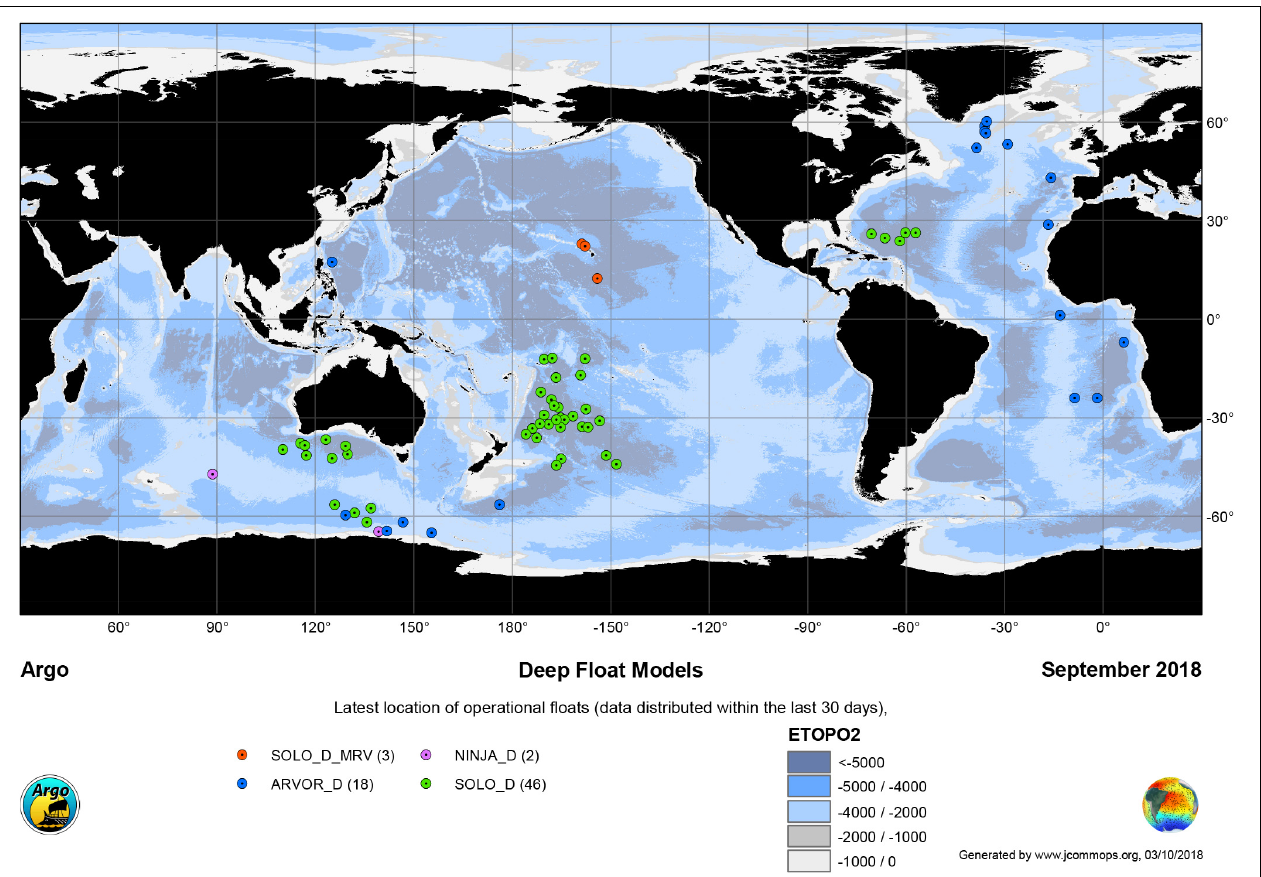
FIGURE 9 | Map of 69 operational Deep Argo floats in September 2018 (rounded symbols), including 46 Deep SOLOs, 3 MRV Deep SOLOs, 18 Deep Arvors, and 2 Deep NINJA. The underlying color indicates bottom depth shallower than 1000 m (white), depth between 1000–2000 m (light gray), 2000–4000 m (light blue), 4000–5000 m (dark blue), and greater than 5000 m (dark gray) (Source: